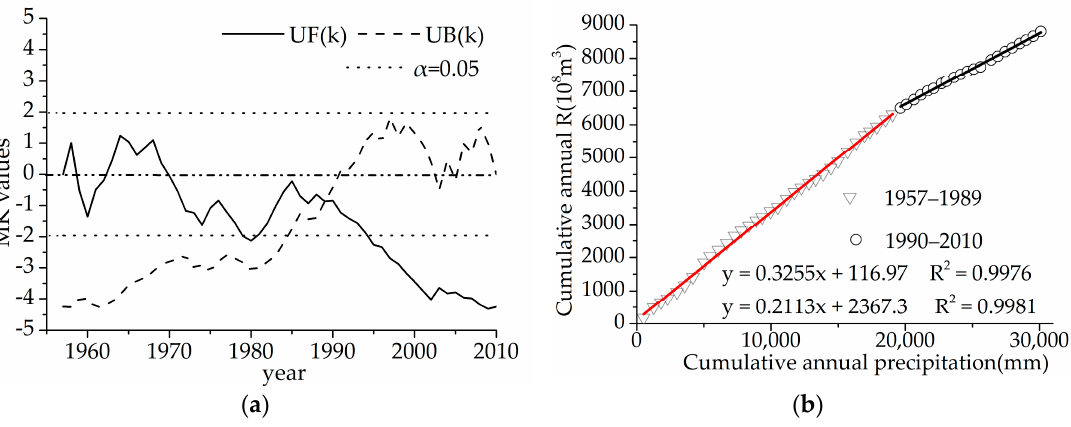
Figure 2. Mann–Kendall test values ( a ) and precipitation–streamflow double cumulative curve ( b ) for change-point detection in Long-Hua region of YRB (1957–2010).